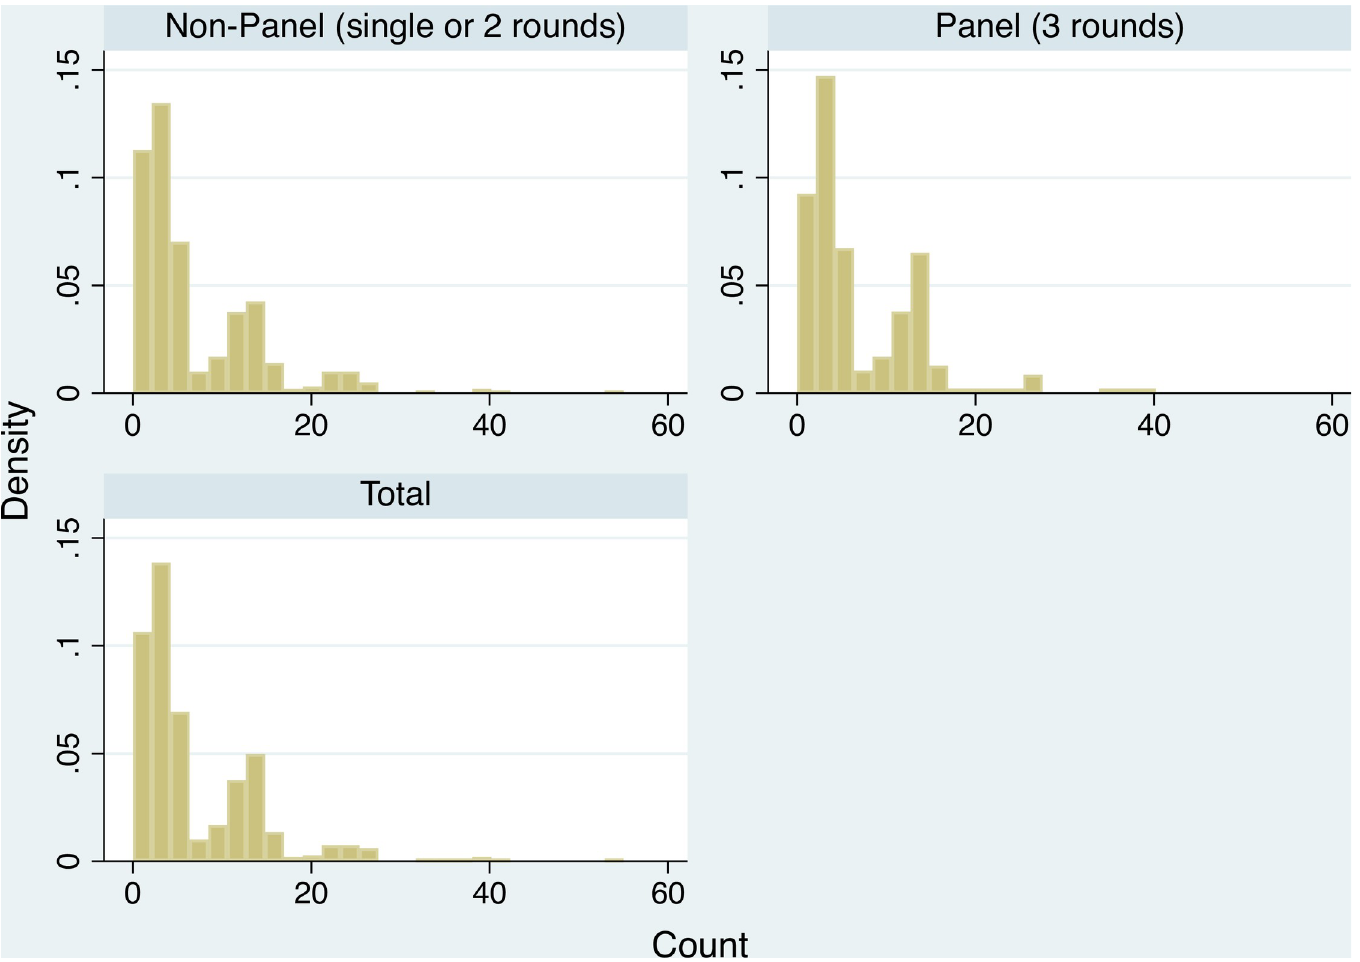
Fig 2. Count scores–panel vs non-panel. Histogram (density) of Count scores.